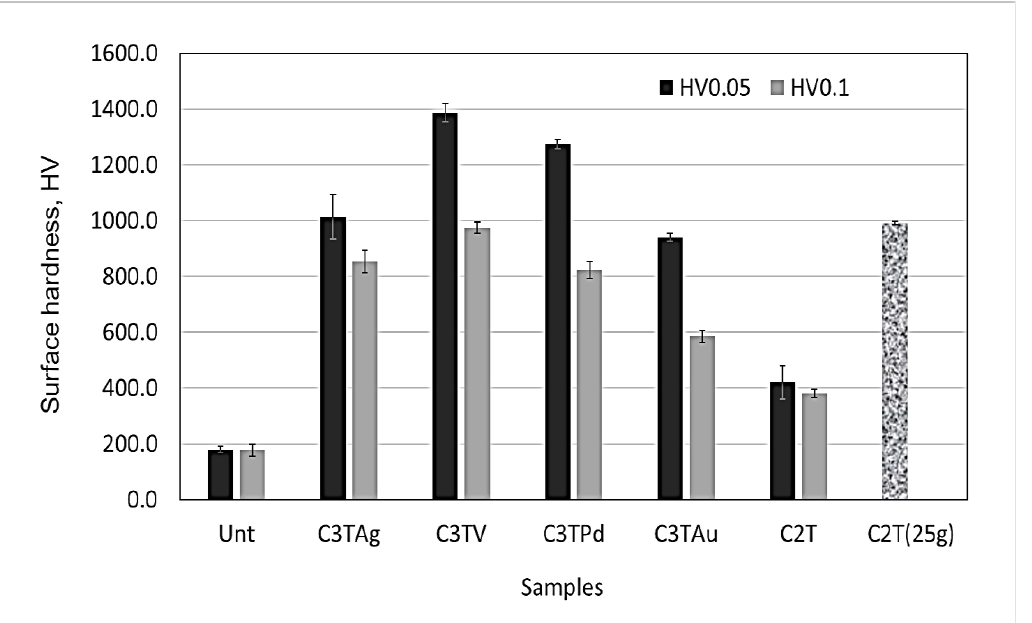
Figure 6. Surface hardness of C2T- and C3T-treated (600 °C, 10 h) samples, in comparison with untreated sample.